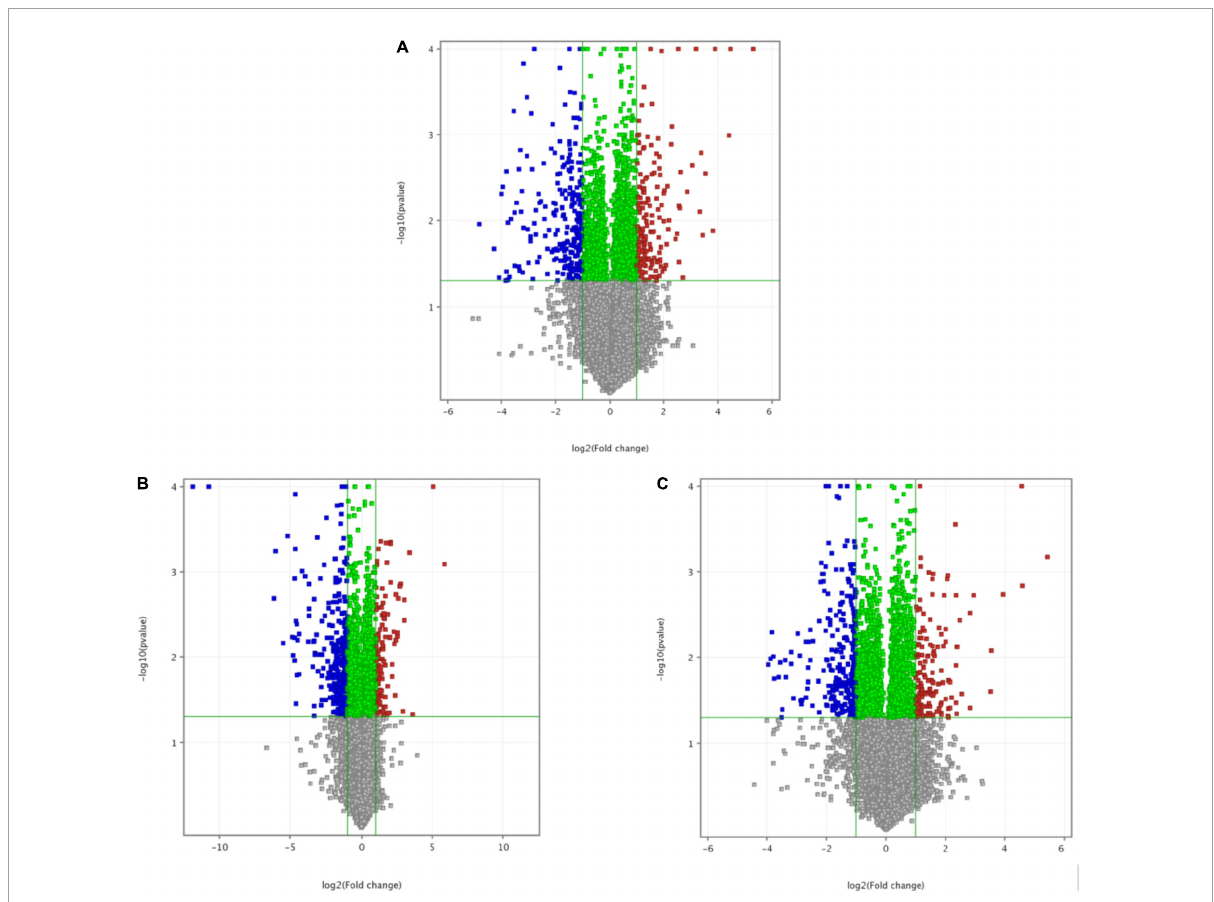
FIGURE2 A differential gene volcano map of intervention groups compared with the model control group. (A) Volcano map of model control group and chrysanthemum flavonoids intervention group. (B) Volcano map of model control group and luteolin intervention group. (C) Volcano map of model control group and luteoloside intervention